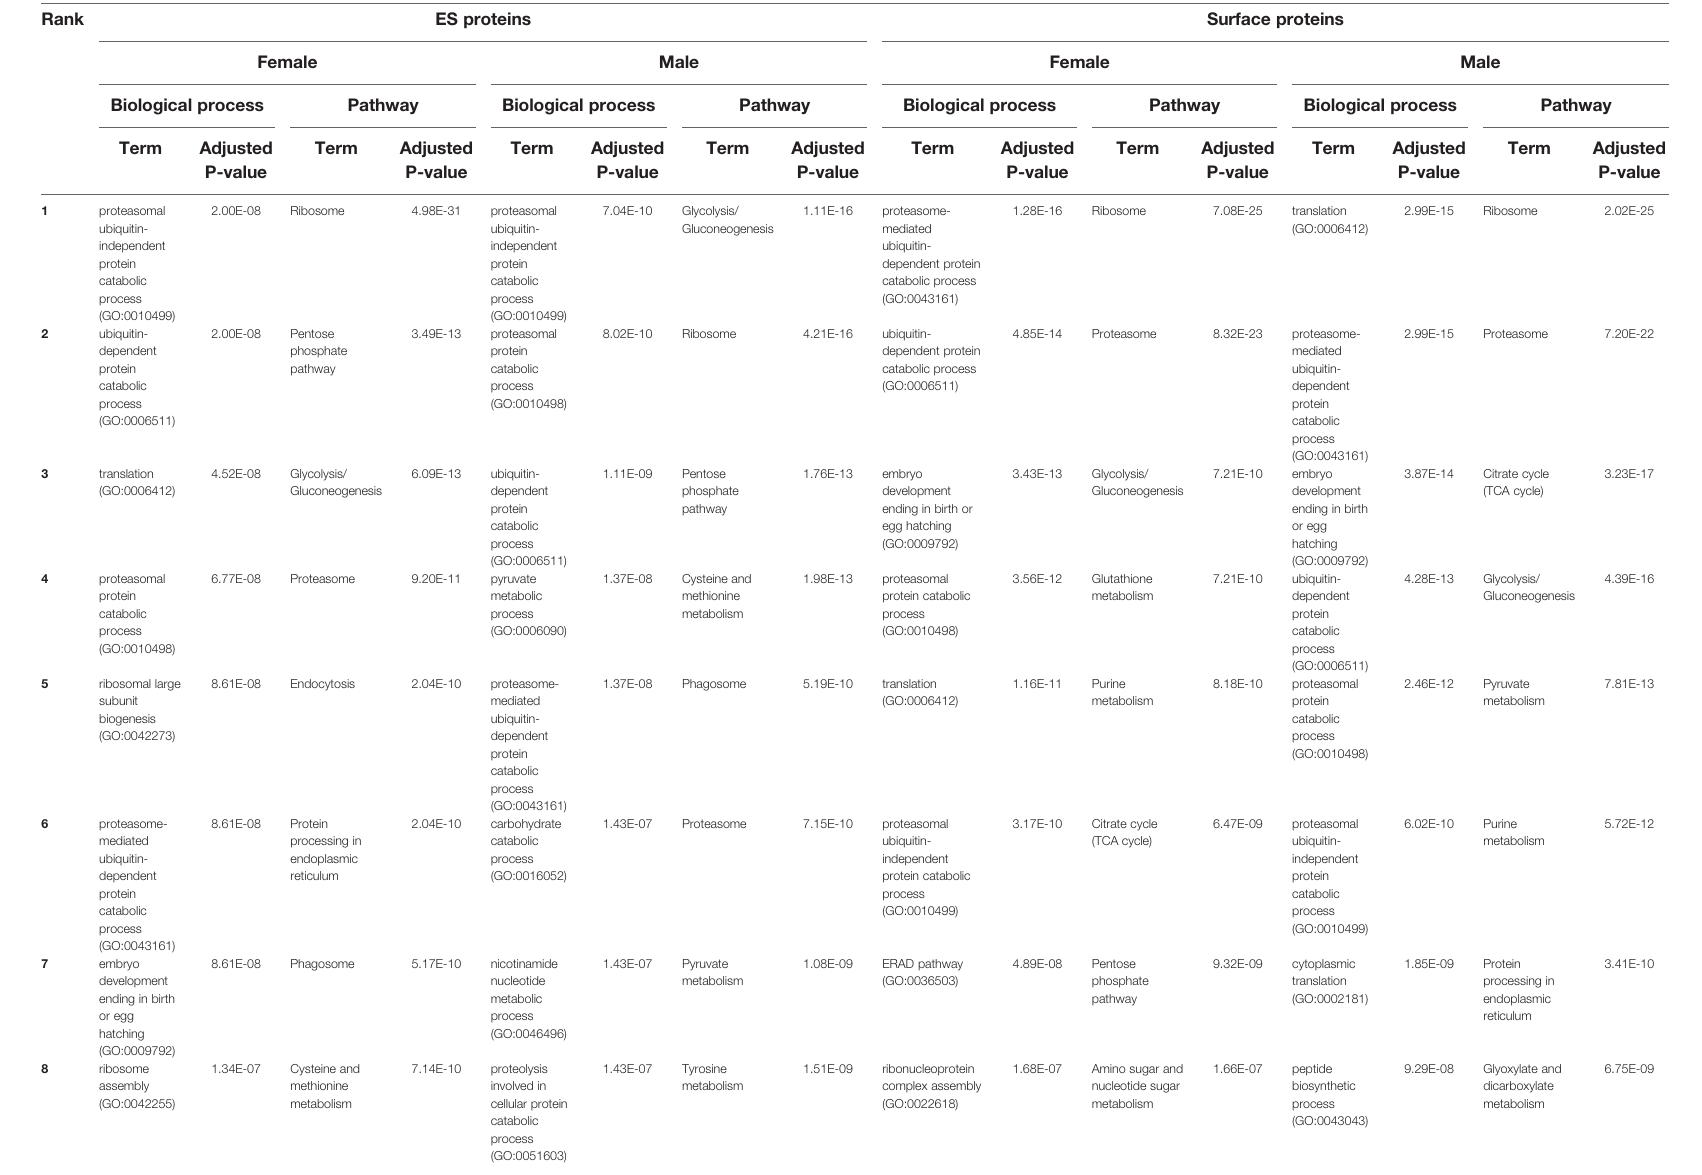
TABLE 1 | Top 10 biological processes and KEGG pathways for Angiostrongylus vasorum female and male excretory/secretory (ES) and surface proteins (obtained using C. elegans orthologue accessions).